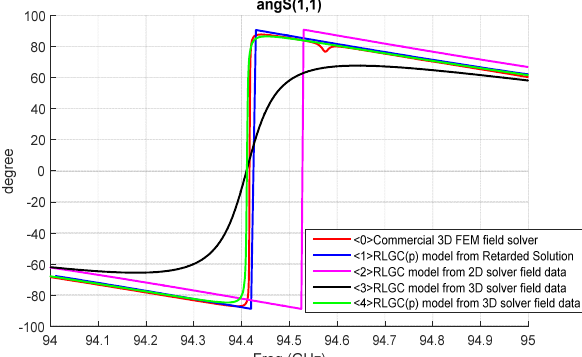
Figure 13: Phase of S11 from 94 GHz to 95 GHz